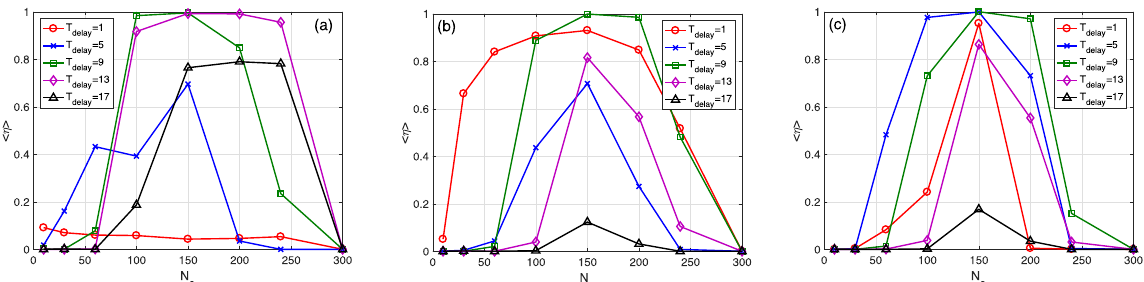
Figure 8. Balance between N a and k a for a fixed N a ⋅ k a . ( a ) Mean survival ratio 〈 η 〉 VS N a for the uniformly random selection with different T delay . SF networks. N = 1000, M = 1000, γ = 1.8, k s = 5, q = 0.39, and f = 0.2. N a ⋅ k a = 1200. The threshold for determining a total collapse is d = 0.5. ( b ) Similar to (a) but for the roulette selection. ( c ) Similar to (a) but the anti-roulette